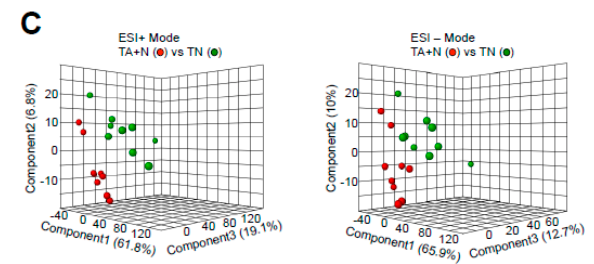
Figure 1. Partial least-squares discriminant analysis (PLS-DA) plots. ( A ) ESI + and − modes of control vs. vitamin E nicotinate (TN); ( B ) ESI + and − modes of control vs. vitamin E acetate + niacin (TA + N); ( C ) ESI + and − modes of TN vs. TA + N. Human pulmonary artery smooth muscle cells were treated with either TN (100 µ M) or with TA (100 µ M) plus niacin (100 µ M) (TA + N) for 10 min. Samples were subjected to metabolomics analysis ( n = 9). ESI: electrospray ionization.